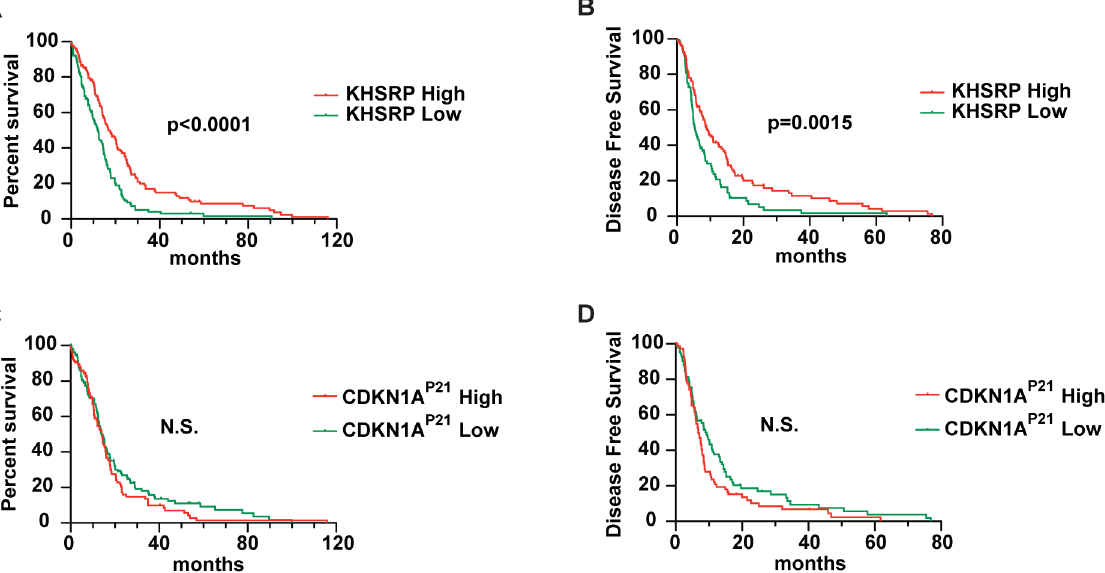
Fig 6. KHSRP transcript levels predict survival of human glioblastoma patients. (A) Overall survival (OS) curves and (B) disease free survival (DFS) curves show an increased OS and DFS of patients bearing tumors with higher KHSRP transcript levels. (C,D) Although not significant, the inverted tendency can be seen when segregating patients in agreement with their tumor CDKN1A P21 transcript levels. Upper and lower quartiles are